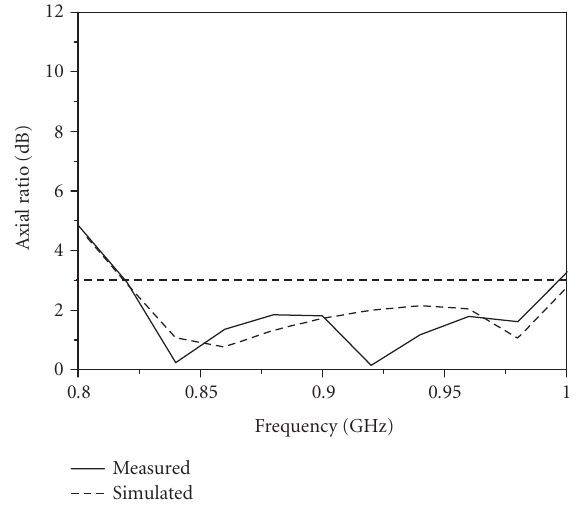
Figure 4: Measured and simulated axial ratios of the proposed an-